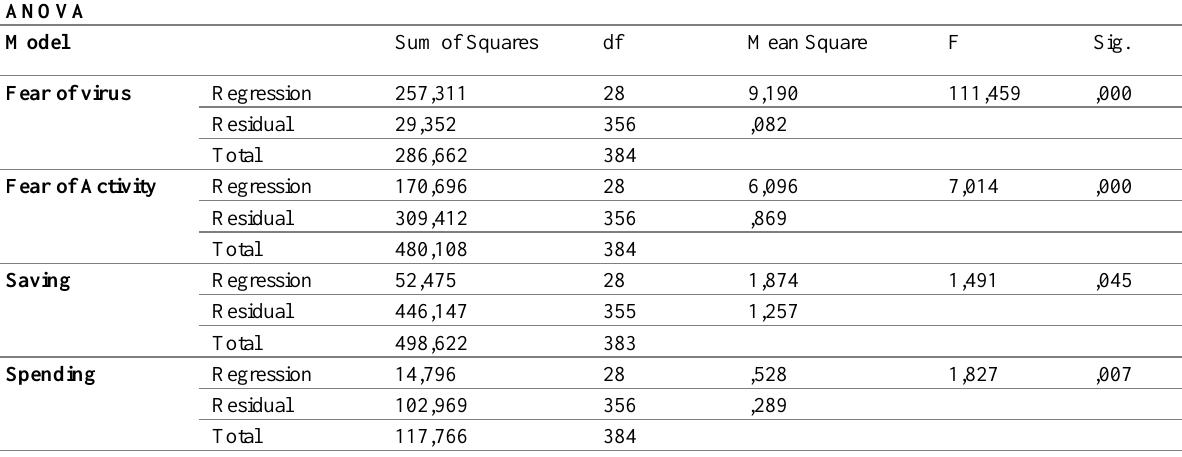
Table 5e: F Test (all of